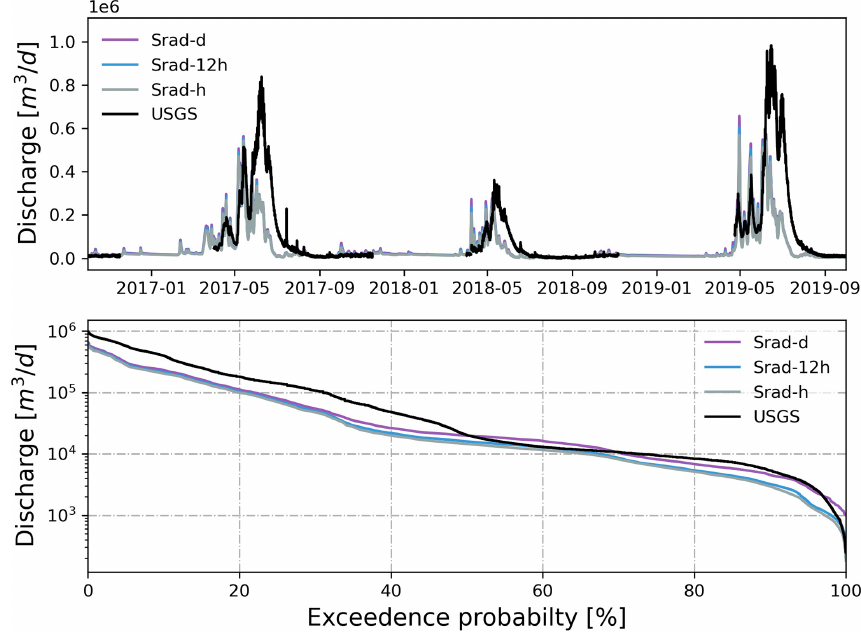
Figure A6. Simulated watershed outlet discharge under different temporal resolutions of S rad . Also shown is the flow duration curve com-